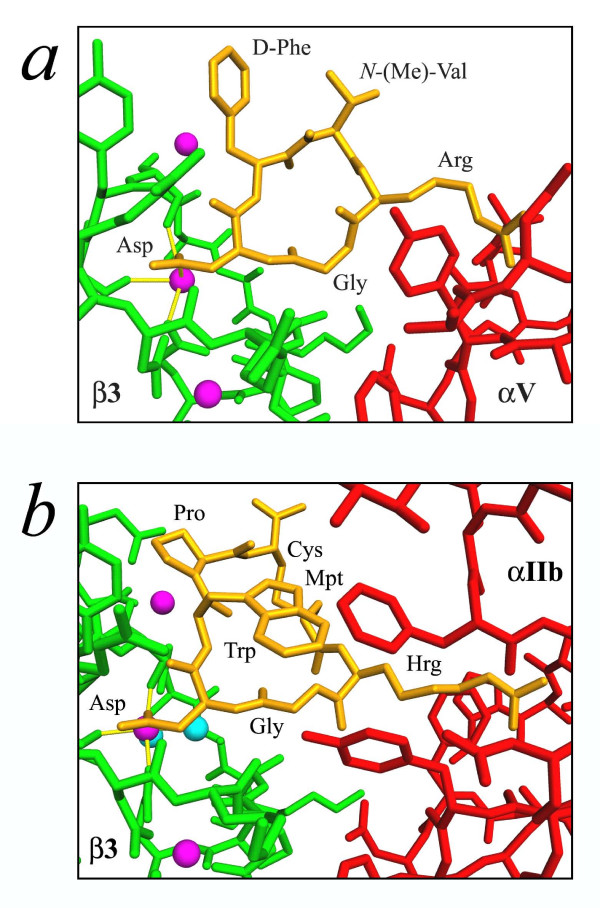
Binding of peptide ligands to the integrin surfaces. (a) Detail of the crystal structure of the extracellular region of αVβ3 integrin in complex with the cyclic pentapeptide Arg-Gly-Asp-D-Phe-N(Me)-Val [8]. The peptide (orange), sits across the interface between the αV (red) and β3 (green) integrin subunits, but only the three amino acids from the RGD triad make significant contact with the integrin surface. The Asp residue completes the coordination of one of the three Mn2+ ions (purple spheres) at the top of the β3 subunit. (b) Detail of the crystal structure of the extracellular region of αIIbβ3 integrin in complex with the cyclic peptide eptifibatide [12], showing very similar interactions. Hrg and Mpt indicate L-homoarginine and β-mercaptopropionic acid residues, respectively. Due to higher resolution, water molecules (cyan spheres) are seen in this structure to complete the coordination of the metal ions. Other colours as in panel a. Both figures have been prepared using SETOR [45].